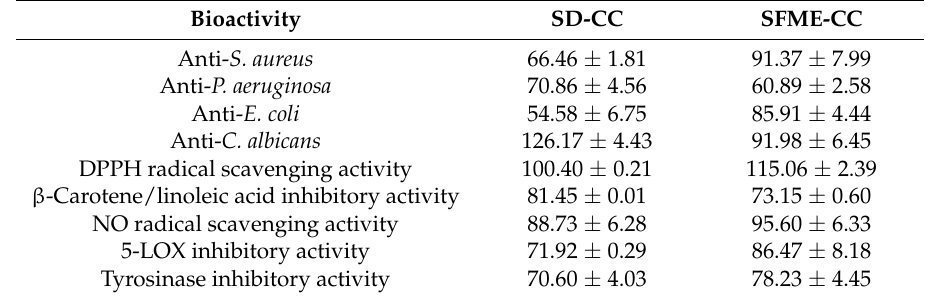
Table 4. Contribution (%) a of mixtures of citronellal and citronellol to the bioactivity of the essential oil.